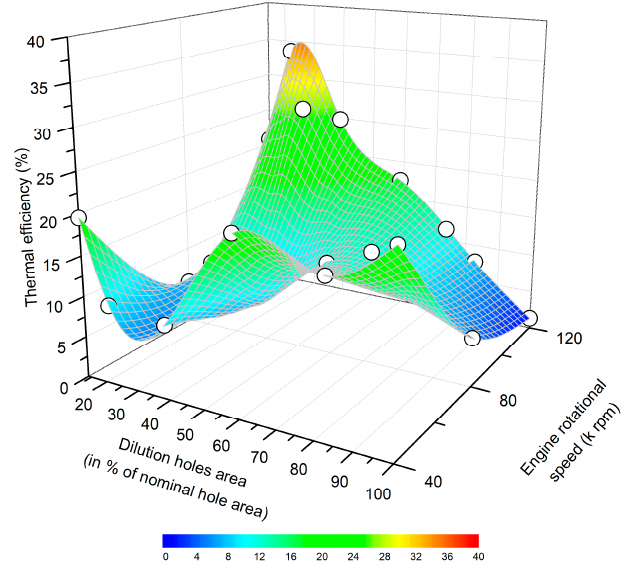
Figure 9. Impact of dilution holes variable geometry on thermal efficiency.